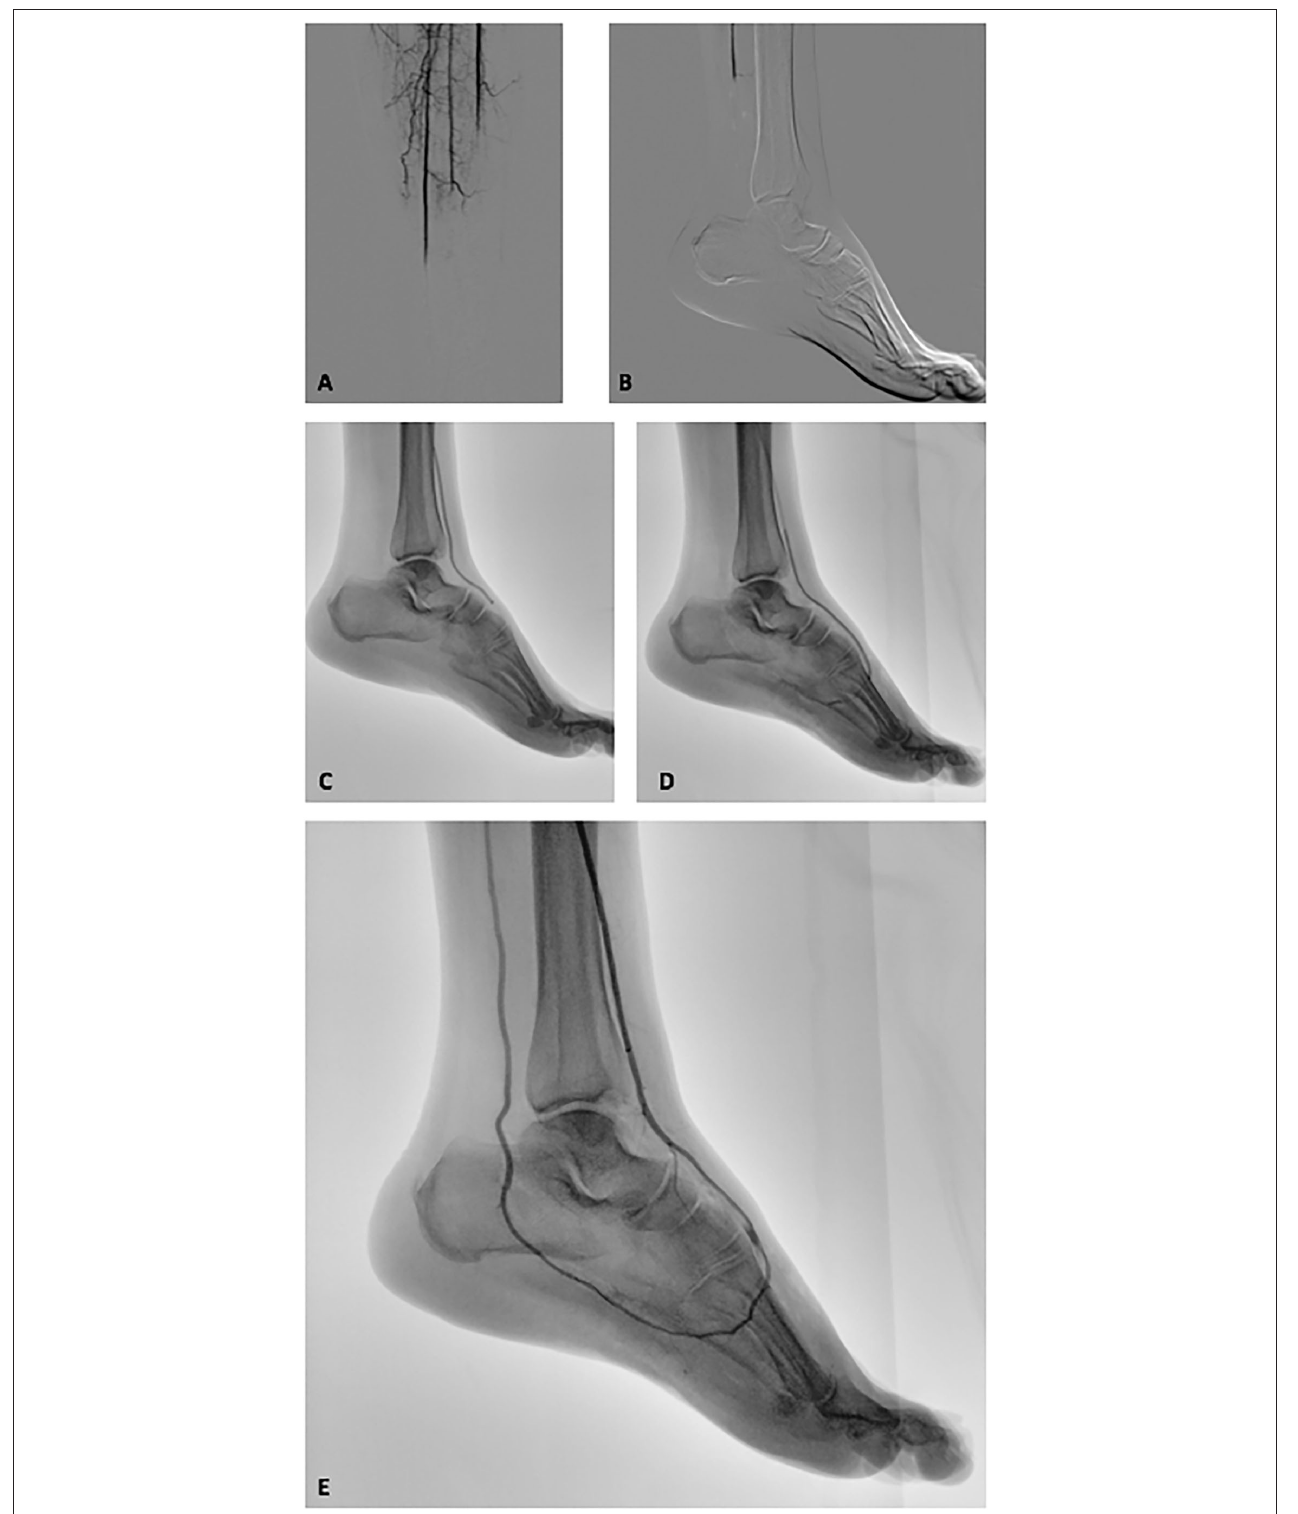
FIGURE 1 | Intraoperative fluoroscopic images of the revascularization procedure of the ischemic lower limb. (A,B) Intraprocedural angiography revealed a below-the-knee complete occlusion on all the tibial vessels and a complete absence of distal foot perfusion. (C) Penumbra Indigo thromboaspiration catheter CAT 6 advanced in the anterior tibial artery and dorsalis pedis. (D) Thromboaspiration catheter CAT 6 advanced into the plantar arch. (E) Post-thromboaspiration angiography revealed the complete recanalization of the anterior tibial artery, dorsal, and plantar arch and posterior tibial artery. A near-complete absence of interdigital arteries and distal vasculature opacization is also